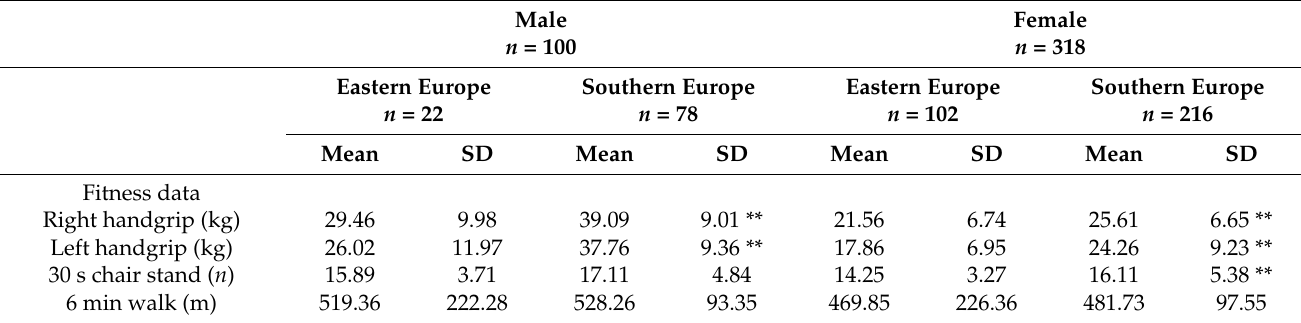
Table 2. Results for physical fitness tests for